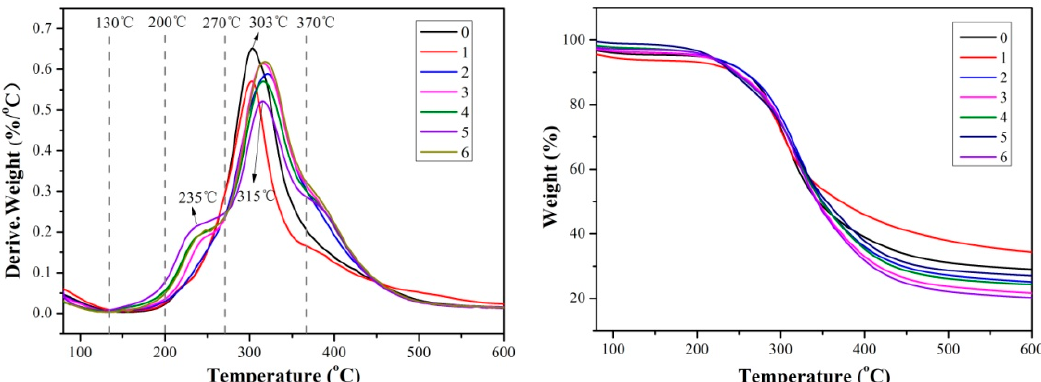
Figure 6. Thermogravimetric (TG, left ) and derivative thermogravimetric (DTG, right ) curves of the different adhesive samples: 0 (12 wt% SPI), 1 (18 wt% SPI/bromelain), 2 (18 wt% SPI/bromelain/3 wt% TGA), 3 (18 wt% SPI/bromelain/6 wt% TGA), 4 (18 wt% SPI/bromelain/9 wt% TGA), 5 (18 wt% SPI/bromelain/12 wt% TGA), and 6 (18 wt% SPI/9 wt% TGA).